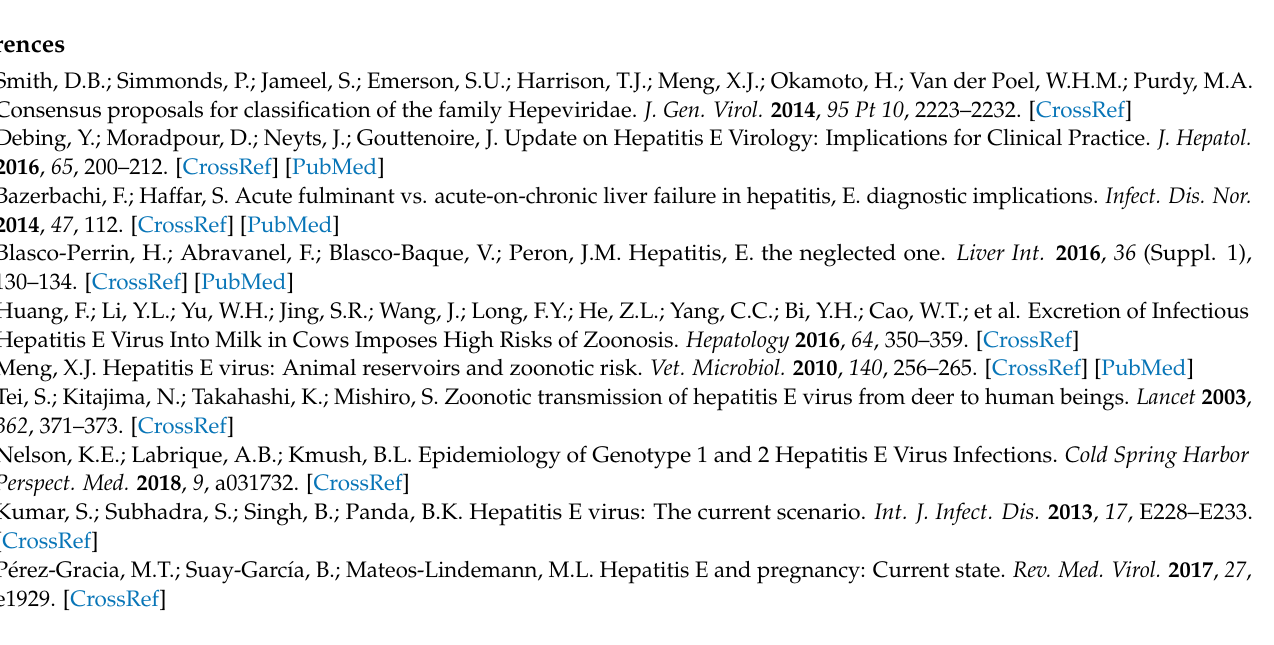
mating for 10 days. Figure S2: The concentration of progesterone in mock or HEV infected female mice. Figure S3: Uterine environment of pregnant mice after